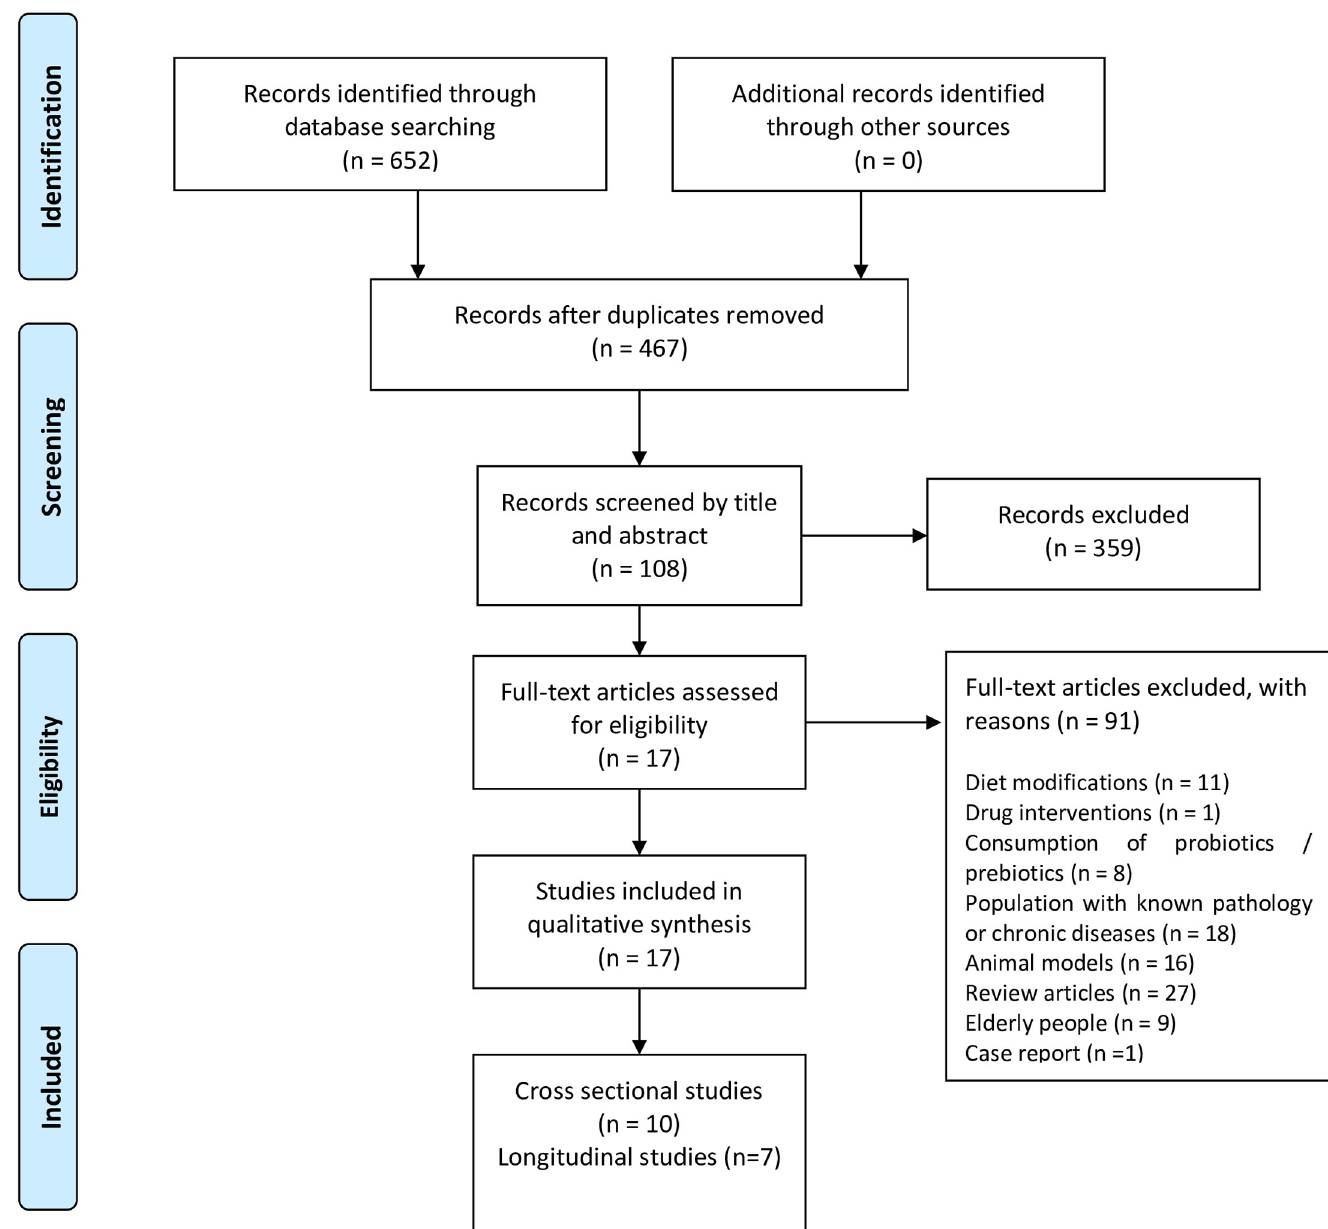
Fig 1. PRISMA flow diagram employed for this systematic